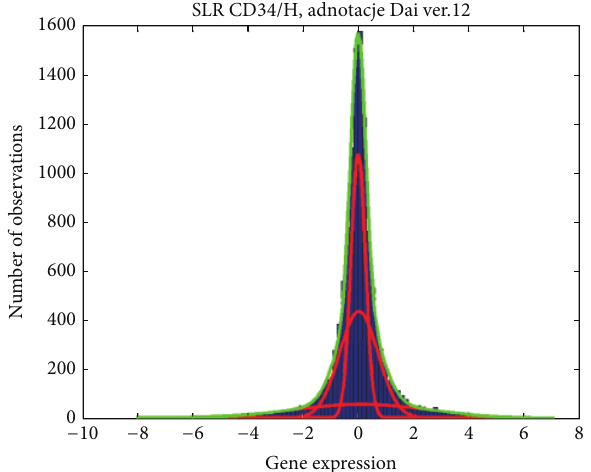
Figure 1: Mixture model of normal distributions (Gaussian Mixture Model) for a mean SLR (Signal Log Ratio) of CD34 − cells from umbilical cord blood versus CD34 − cells from bone marrow. Log (CD34-P)/(